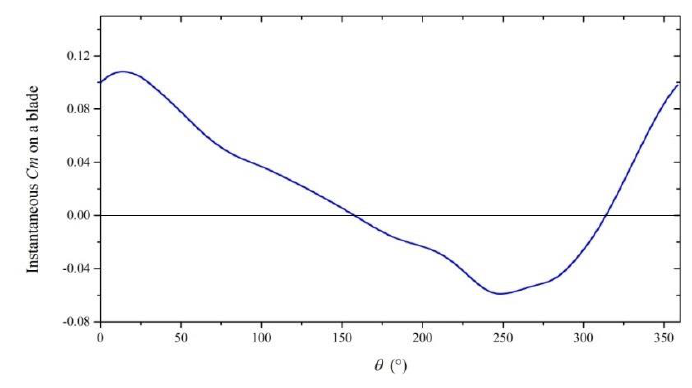
Figure 18. The instantaneous coefficient of torque on a blade at φ = 0° and TSR = 0.4.